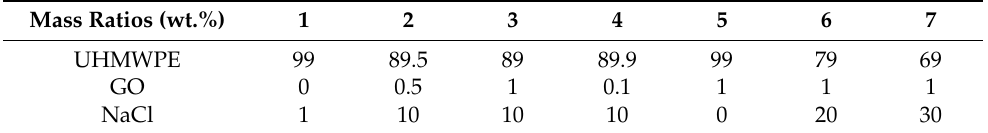
Table 1. Mass ratios of surface porous GO/NaCl/UHMWPE composites. Mass Ratios